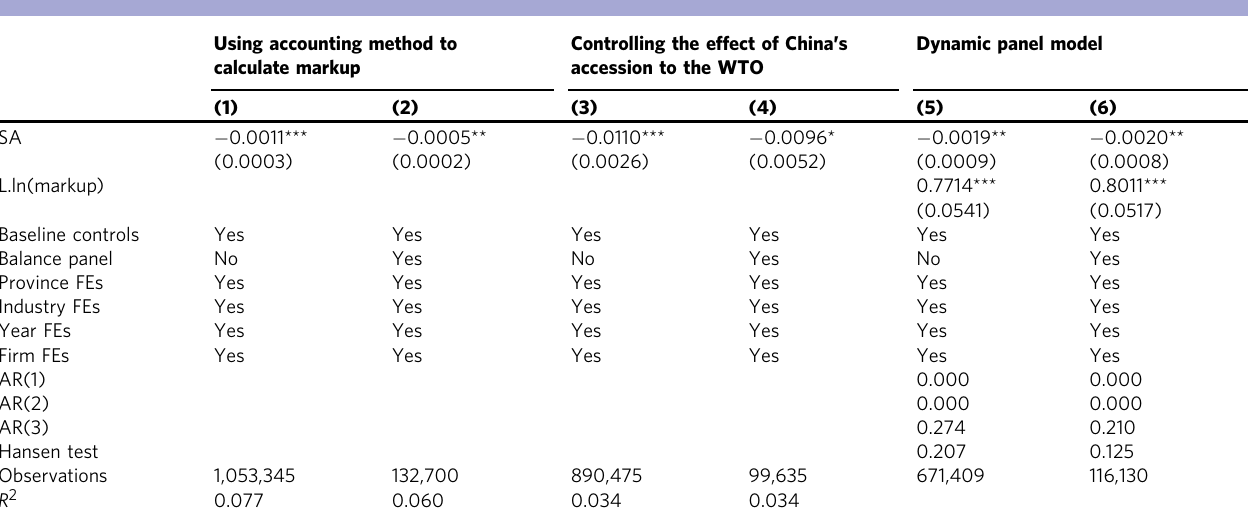
Table 6 Results of robustness